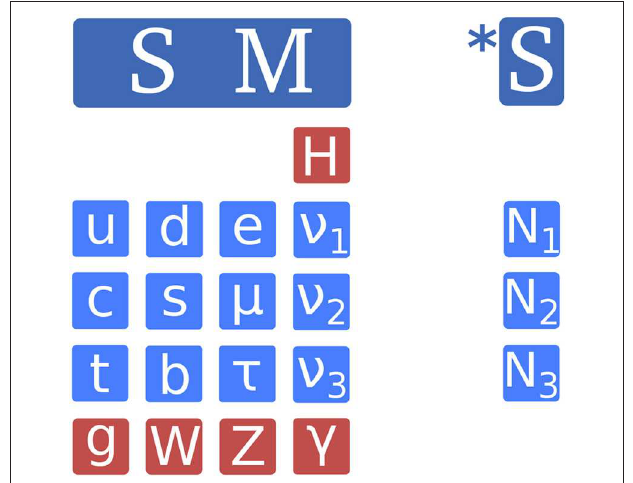
FIGURE 1 | Particle/field content of the ν